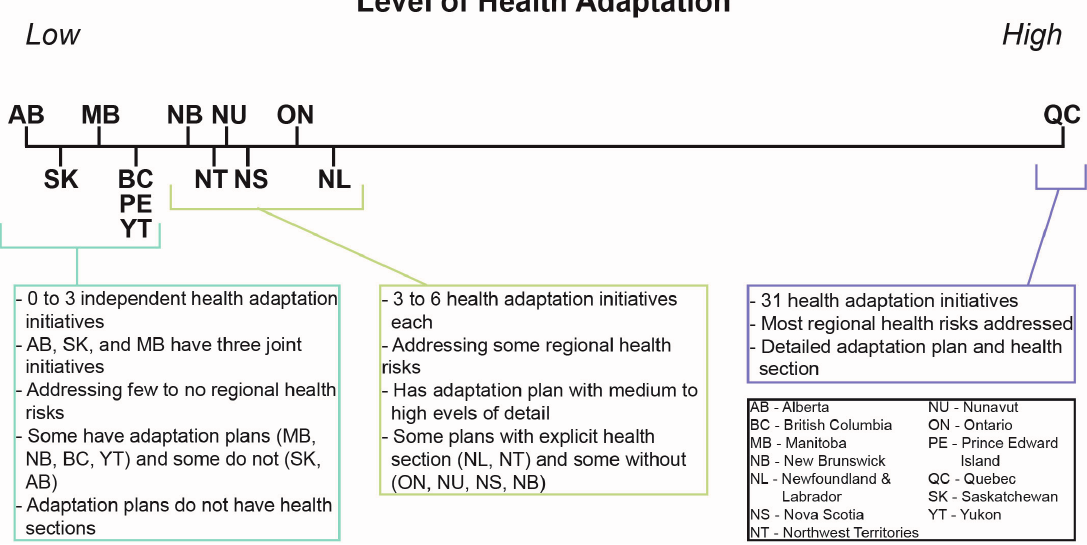
Figure 6. Level of health adaptation by province or territory a . a The provinces and